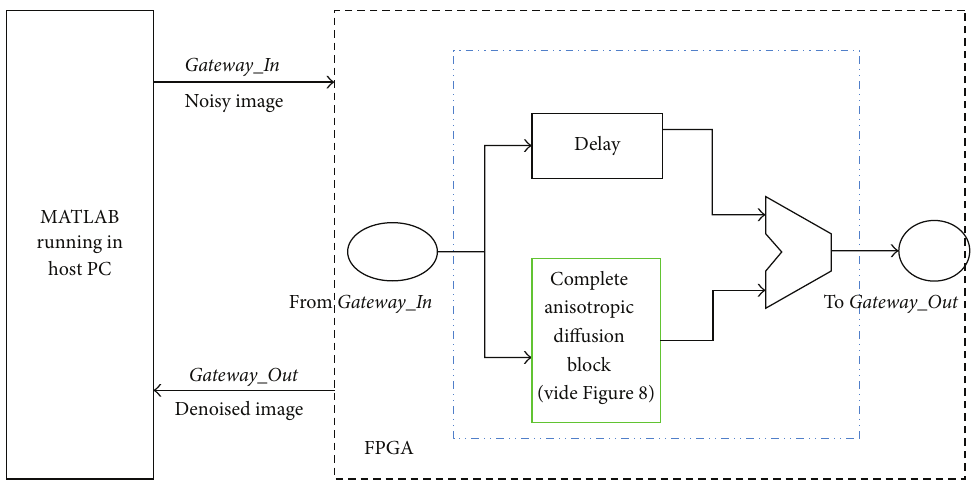
Figure 7: This hardware design shows a single instance of the iterative diffusion step shown in (3). The overall architecture with the pixels passing from the host PC to the FPGA platform and the processed pixels being reconstructed back to the host PC.